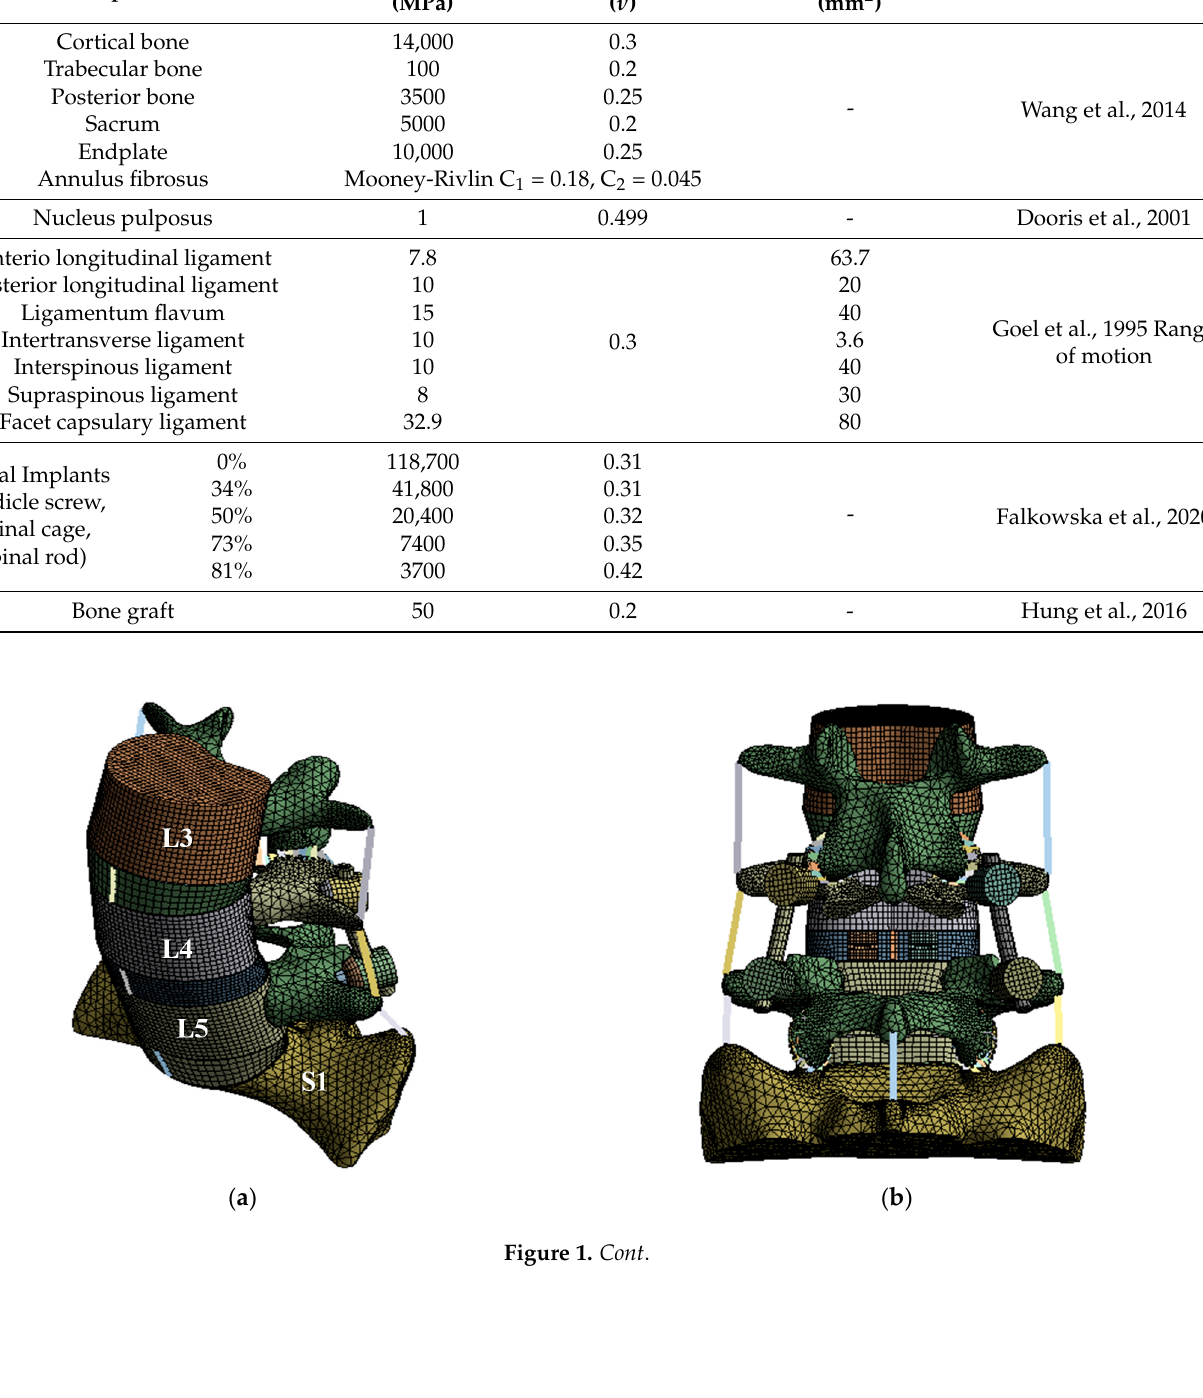
Table 1. Material properties of lumbar spine and spinal implants.